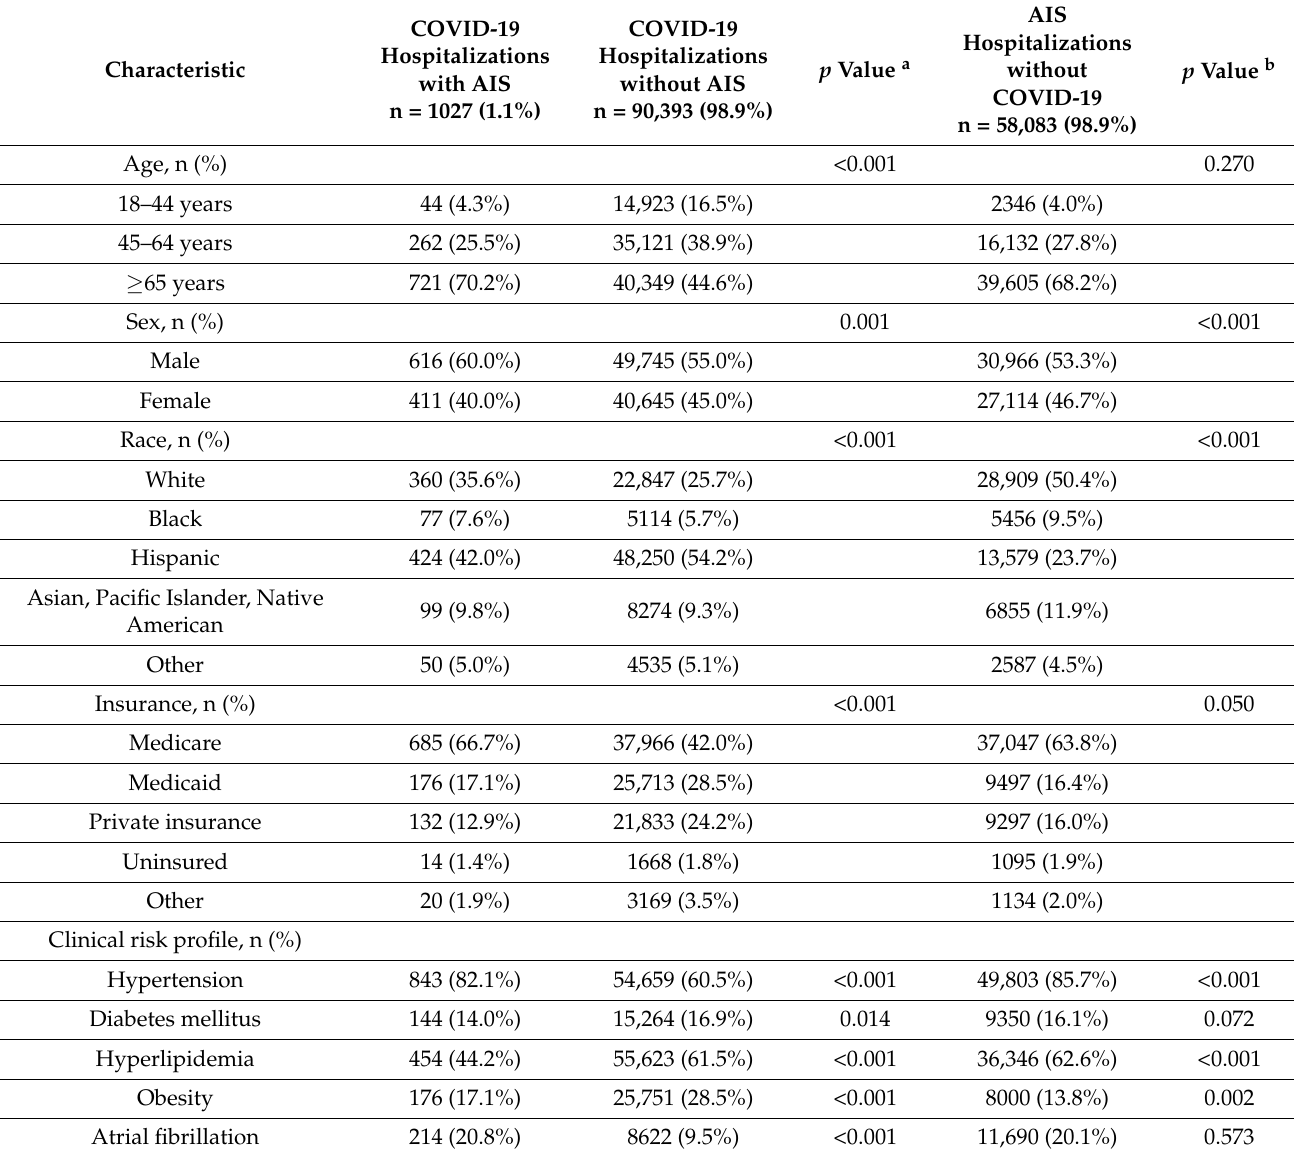
Table 1. Demographic and clinical characteristics of hospitalized COVID-19 patients with and without